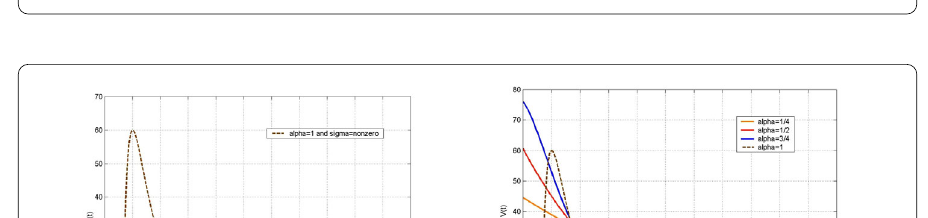
Figure 4 Graphs of Eq. (9) with selected α and σ values